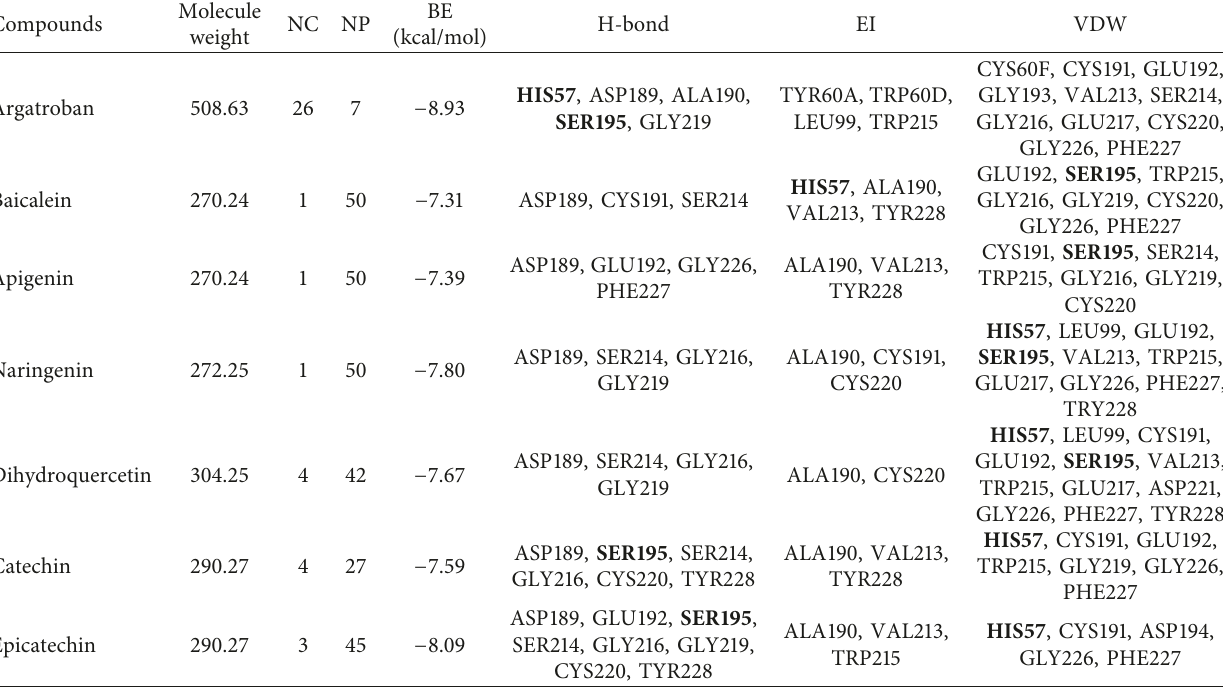
Table 2: The docking results and residue interactions of the complexes of argatroban and six flavonoids with thrombin. Compounds